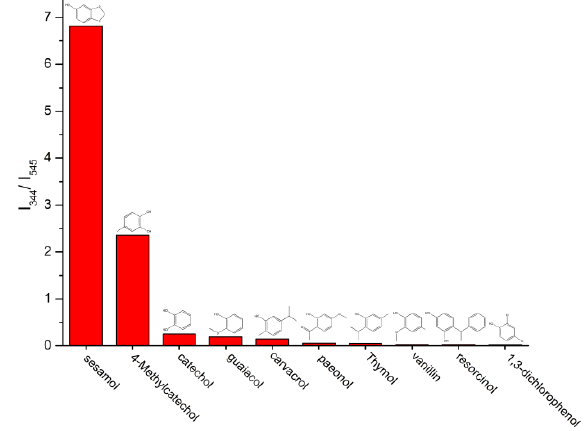
Figure 6. Diagrams of the transition intensities (I 344 /I 545 ) of the Tb@Sr-MOF in various small biomolecules (λex = 294 nm).